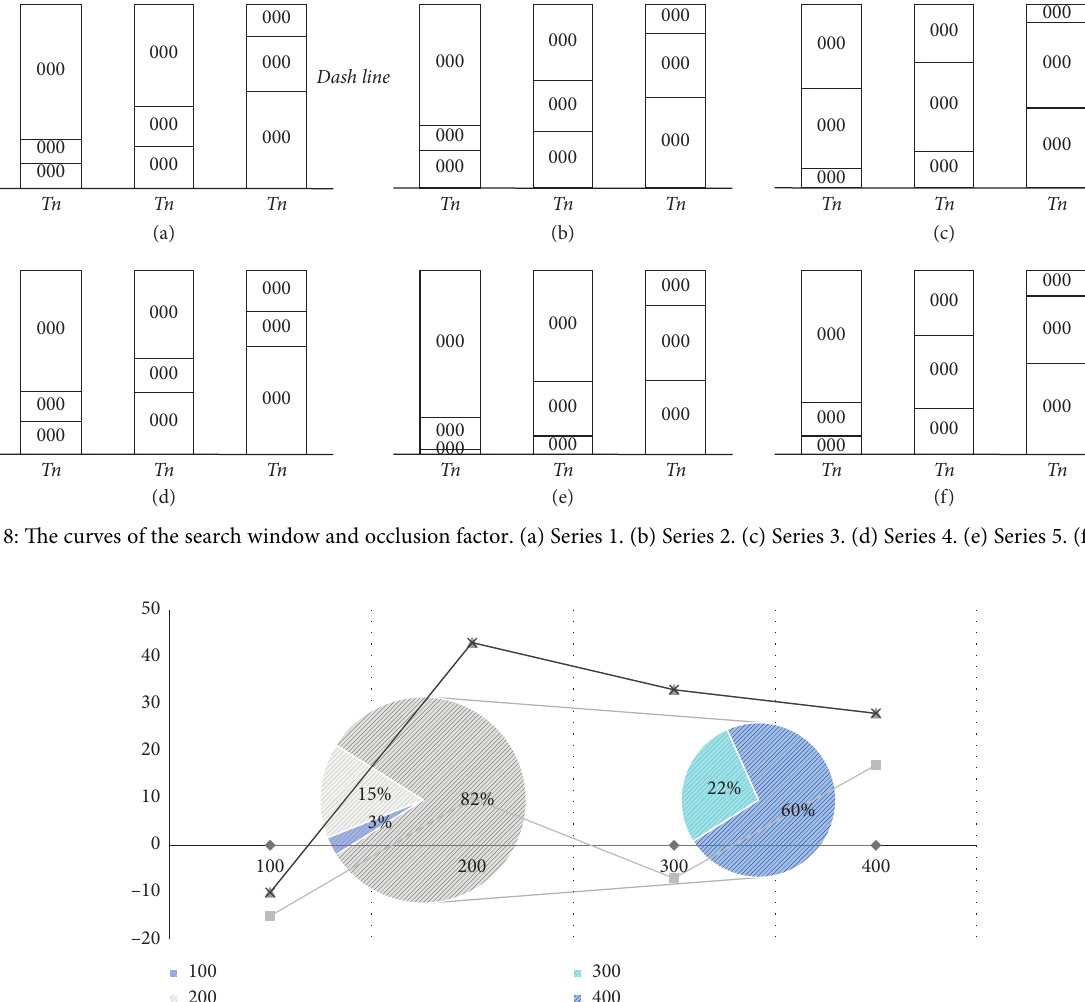
Figure 9: The track feature matching result.